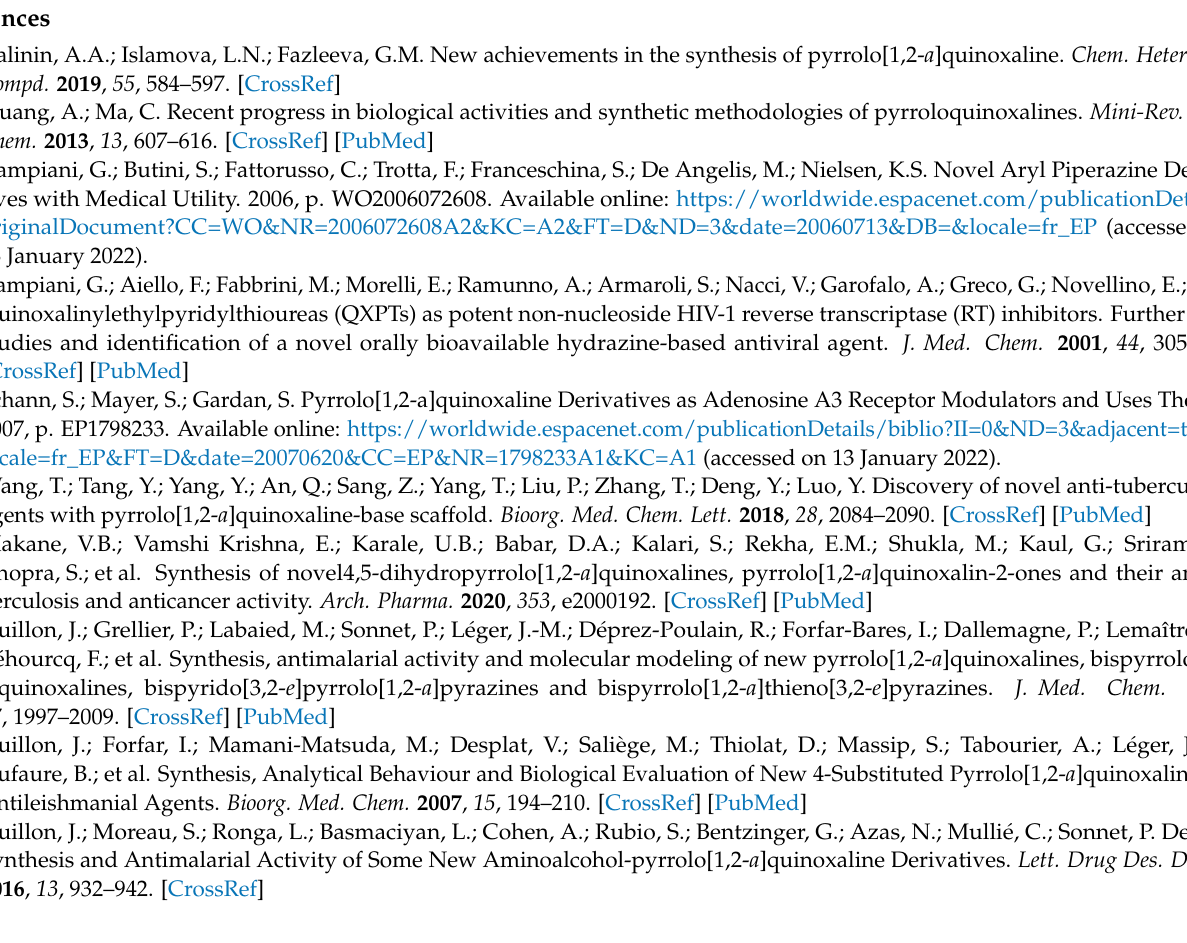
compound 9 ; Figure S3: FT-IR spectrum of compound 9 ; Figure S4: HRMS data for compound 9